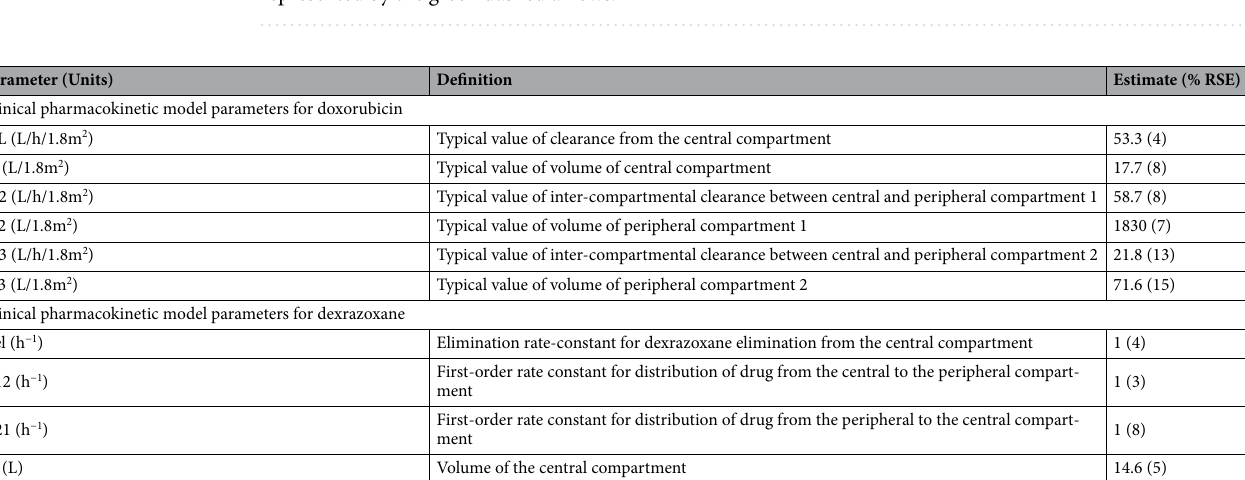
Figure 3. Model structure of clinical pharmacokinetics for doxorubicin (DOX) (3-compartment; Left, Top ) and for Dexrazoxane (DEX) (2-compartment; Left, Bottom ). Schematic of the in vitro cellular-level toxicodynamic model (TD) for the single and combinatorial effects of Doxorubicin (DOX) and Dexrazoxane (DEX) ( Right ) on human cardiomyocytes. Time-varying concentrations were utilized to drive the DOX + DEX TD model as represented by the green dashed arrows.